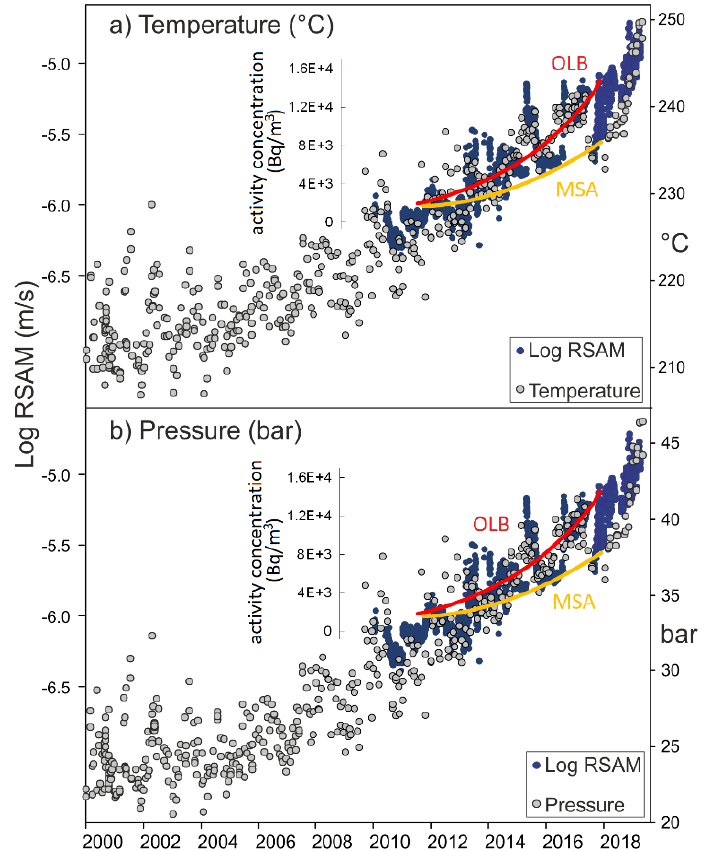
Figure 5. Comparison of temperature ( a ) and pressure ( b ) of the Campi Flegrei hydrothermal system, estimated at Pisciarelli fumarole, with the fumarolic tremor (RSAM) registered at Pisciarelli fumarole and with thoron trends at OLB and MSA sites.